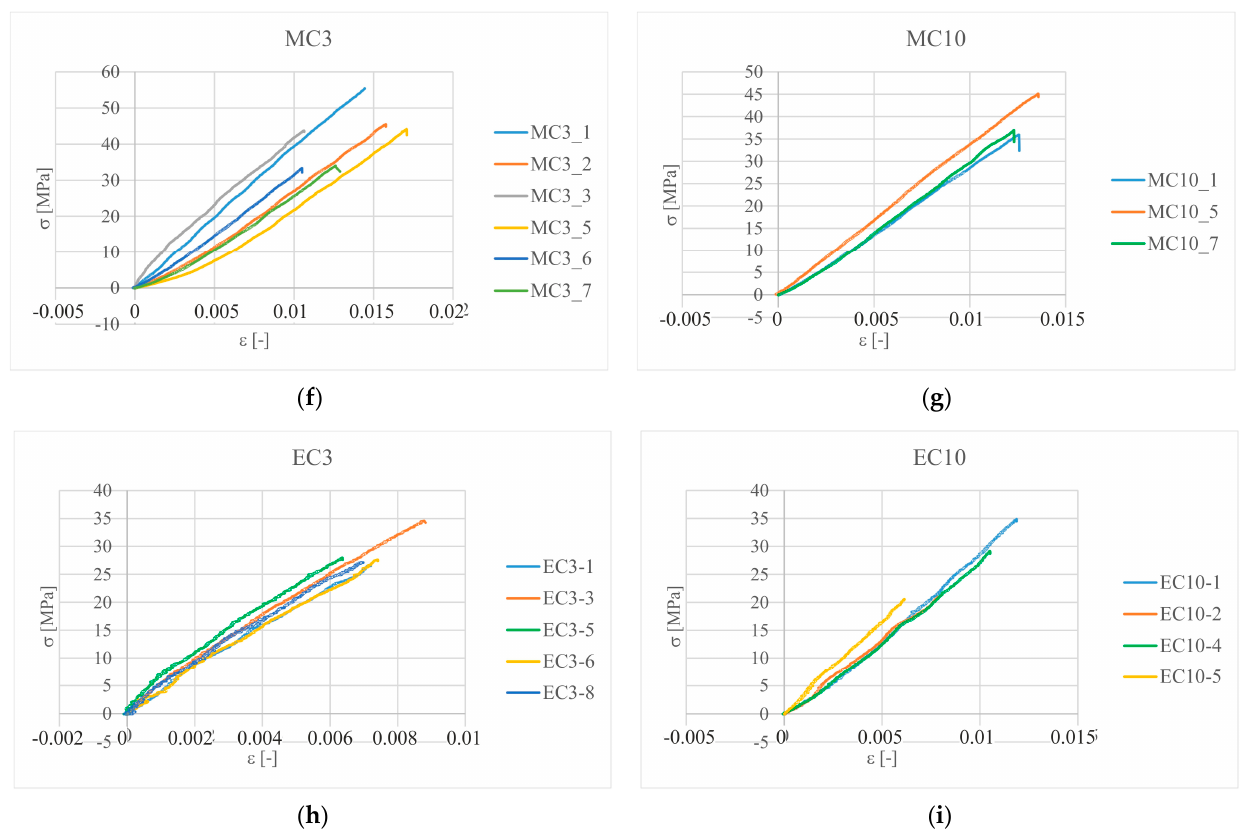
Figure 6. Sets of tensile stress–strain curve for ( a ) epoxy resin without fillers, ( b ) CMC3, ( c ) CMC10, ( d ) ESO3, ( e ) ESO10, ( f ) MC3, ( g ) MC10, ( h ) EC3 and ( i ) EC10.